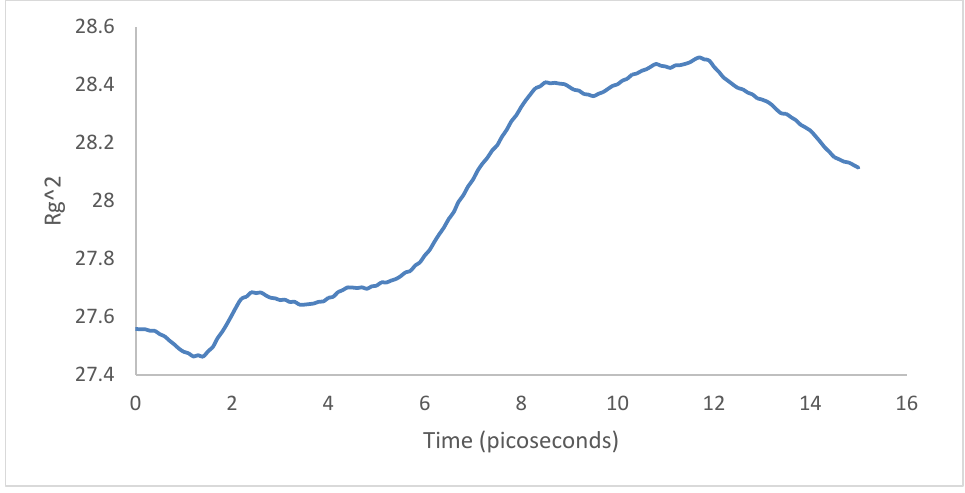
Figure 31. Radius of gyration: 4PPV–CNT.